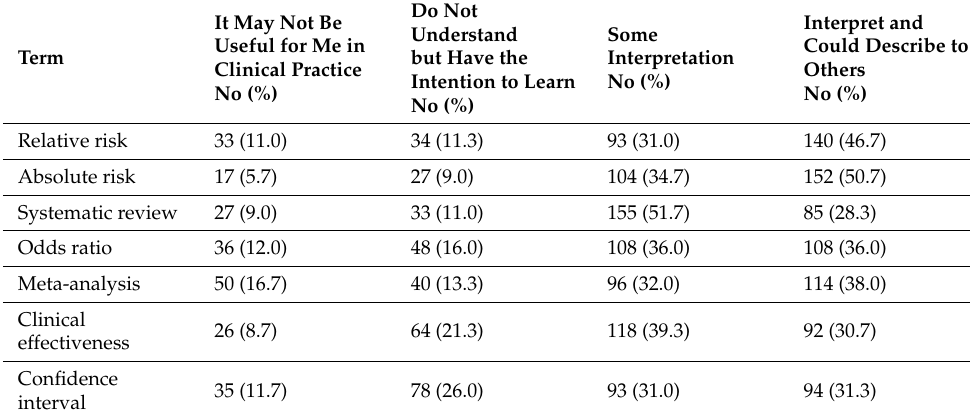
Table 3. Knowledge and awareness regarding technical terms used in EBM (n =